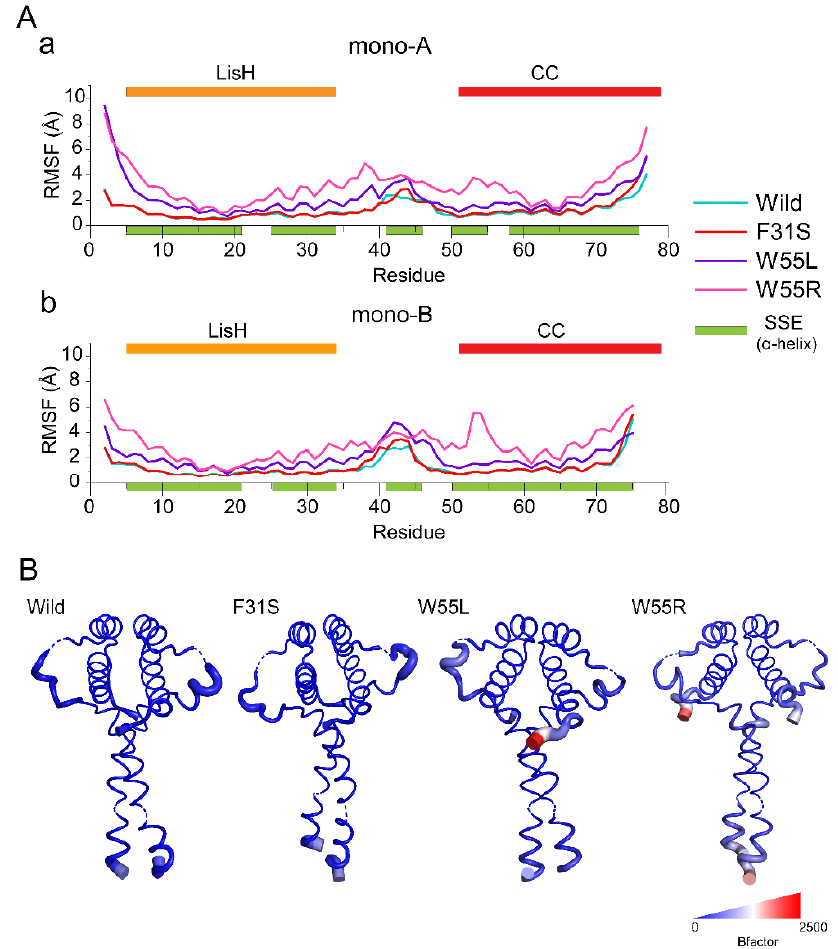
Figure 3. Variant containing structure shows different residual flexibilities during simulation. ( A ) Differences in residual flexibilities are represented by C α -root mean square fluctuation (RMSF) plot for both monomer A ( a ) and B ( b ). The color bar that is highlighted by specific color reflects helix propensity and domain arrangement as in Figure 2. ( B ) Structural comparison showing the variations as B-factor coloration and thickness, which were calculated from RMSF. The coloring was created using a blue-white-red spectrum with values ranging from 0 to 2500. The thickness of the tube also determines fluctuation, where a more major fluctuation corresponds to a thick tube.